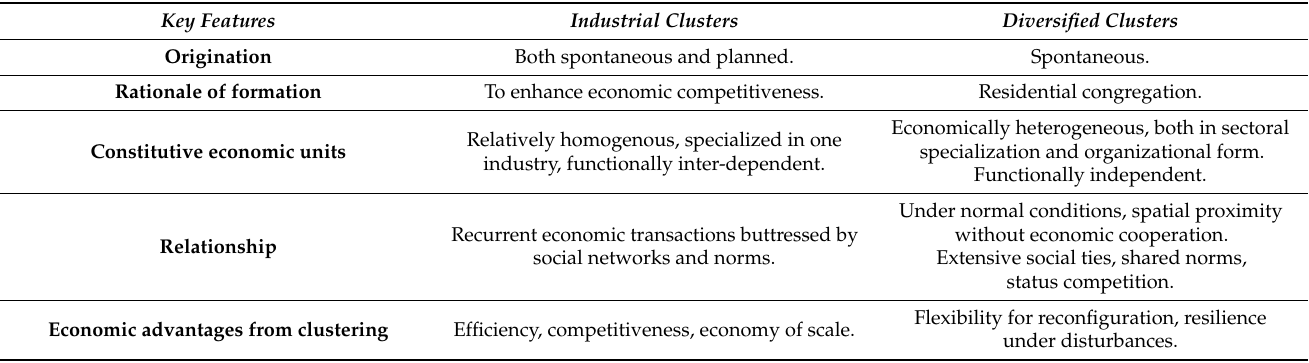
Table 1. A comparison between industrial clusters and diversified